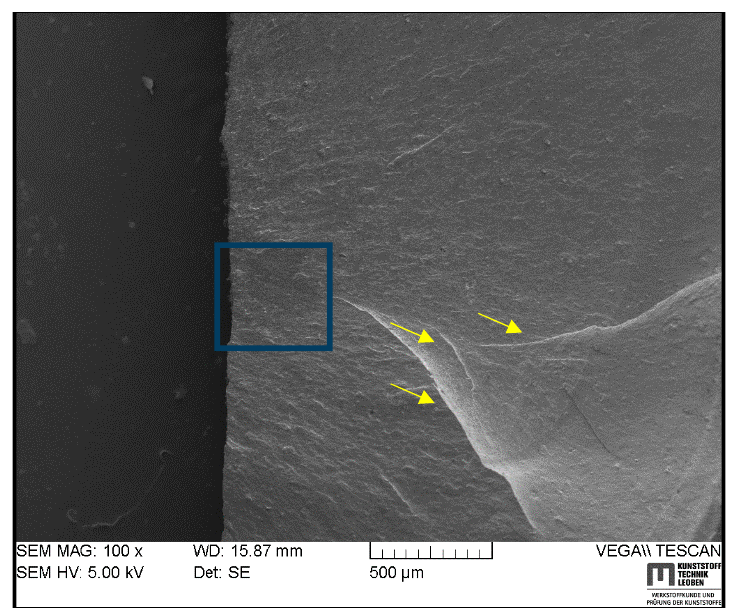
Figure 10. SEM image of a fracture surface starting from low-strength matrix site and a propagation in slow and subsequently fast stable crack growth for HNBR4.